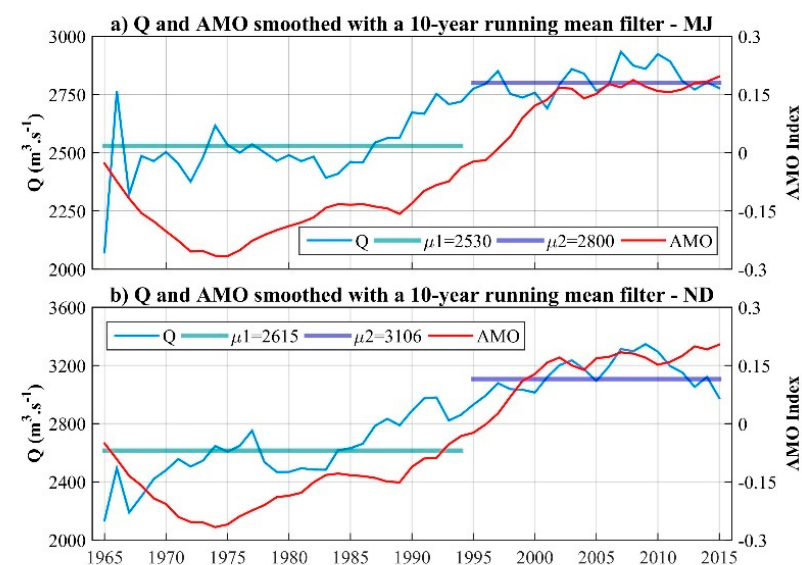
Figure 3. Time series of streamflow (Q) in m 3 ·s − 1 and Atlantic Multidecadal Oscillation (AMO) index smoothed with a 10-year running mean filter for ( a ) May–June (MJ) and ( b ) November–December (ND) during the 1965–2015 period. The blue and purple horizontal lines indicate the average streamflow before and after 1994, respectively.